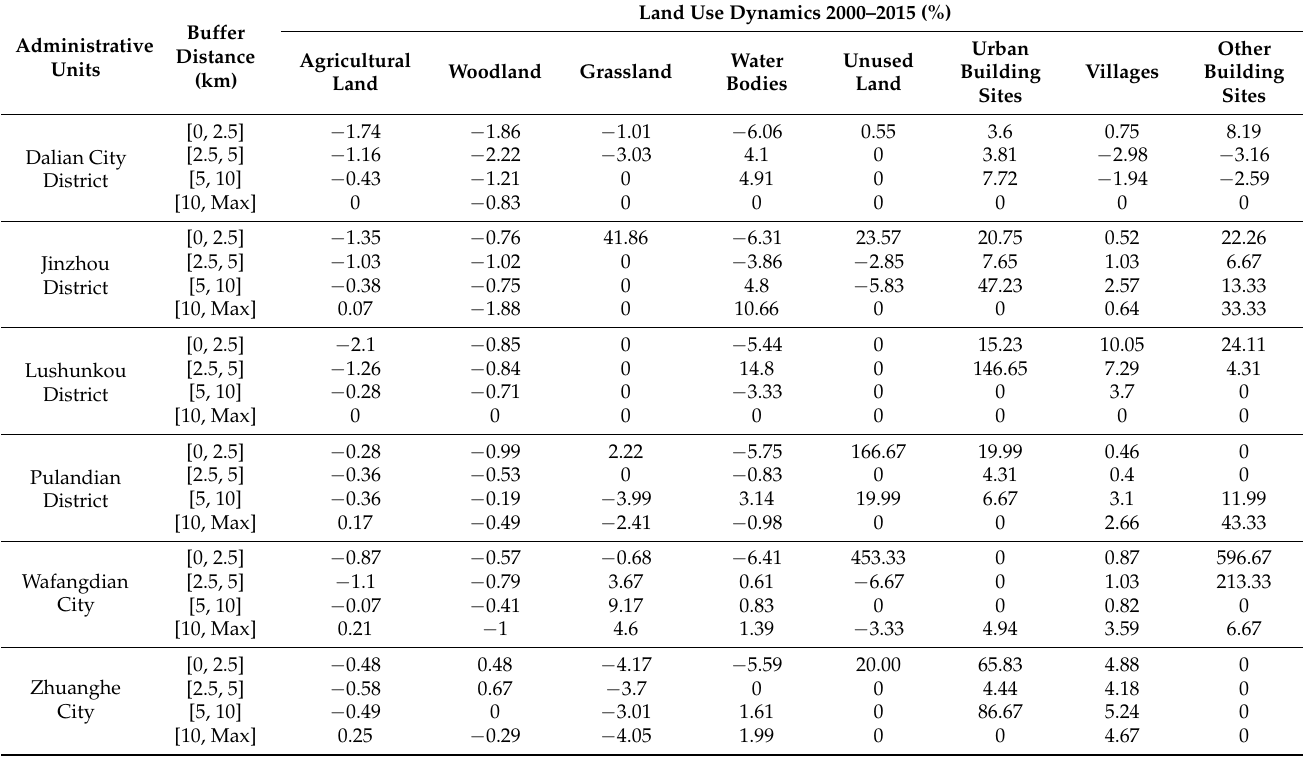
Table 4. Change in dynamic land use attitude gradient by district in Dalian from 2000 to 2015.